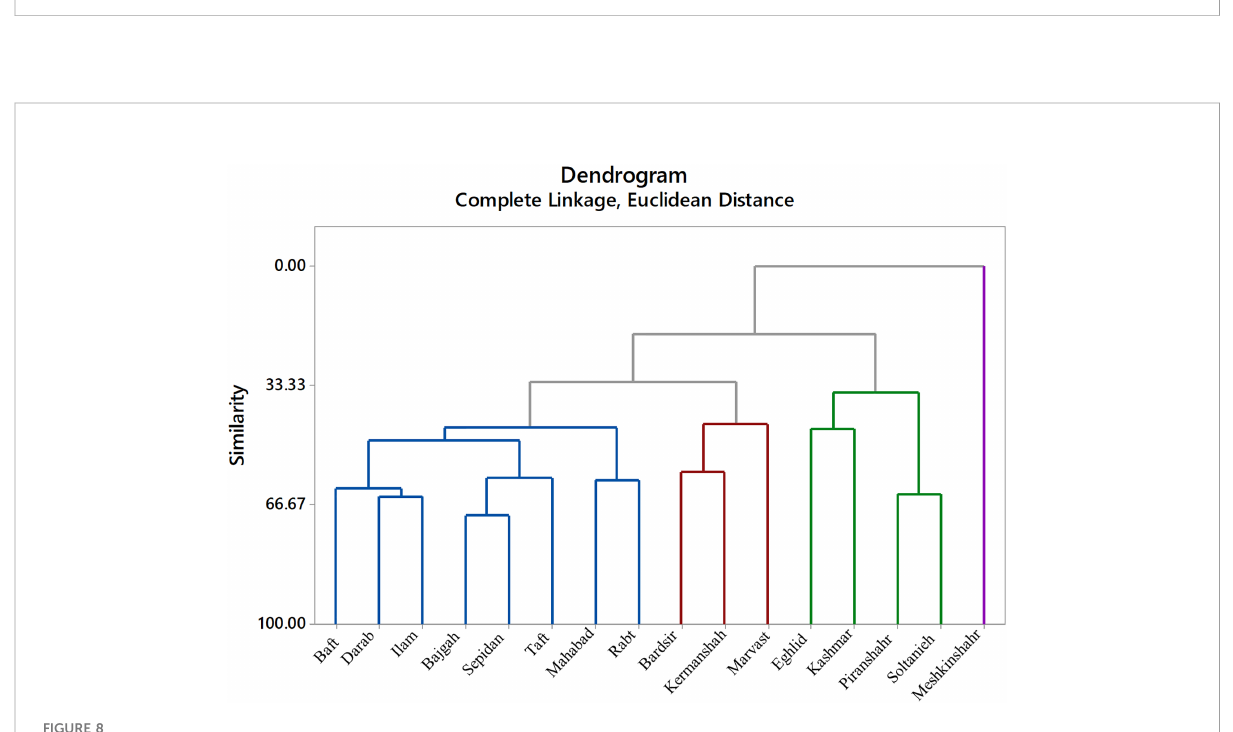
FIGURE 8 Cluster analysis of Iranian licorice accessions under studied